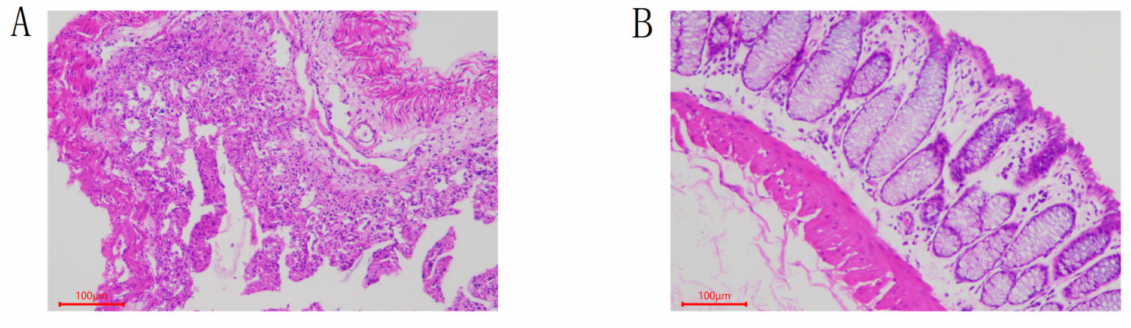
Figure 1. Pathological observation of colon tissue in rabbits by microscope (HE-staining, 100 × ). ( A ) DIA. ( B )